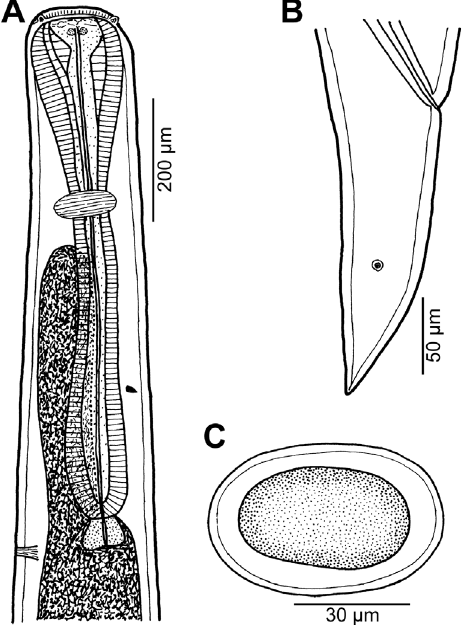
Figure 17. Dichelyne ( Cucullanellus ) sp. from Bodianus perditio , gravid female. (A) Anterior end of body, lateral view; (B) tail, lateral view; (C)